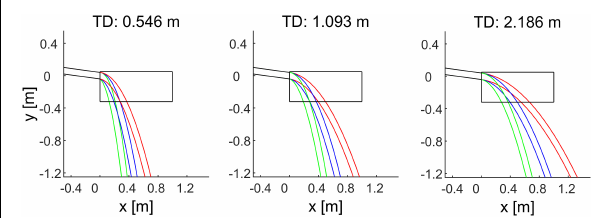
FIGURE 2 | Spatial trajectories of the ball for all experimental conditions. The envelope of the path followed by the ball in the frontal plane is denoted by parallel lines. Black lines indicate the last segment of the rolling motion on the inclined plane. Blue, red, and green lines indicate the trajectories in air for the internally consistent conditions (G 0 , G 1 , G 2 ), the inconsistent condition G 3 , and the inconsistent condition G 4 , respectively. The black box represents the frontal side of the cuboid. Each panel corresponds to a different traveled distance (TD) on the incline.